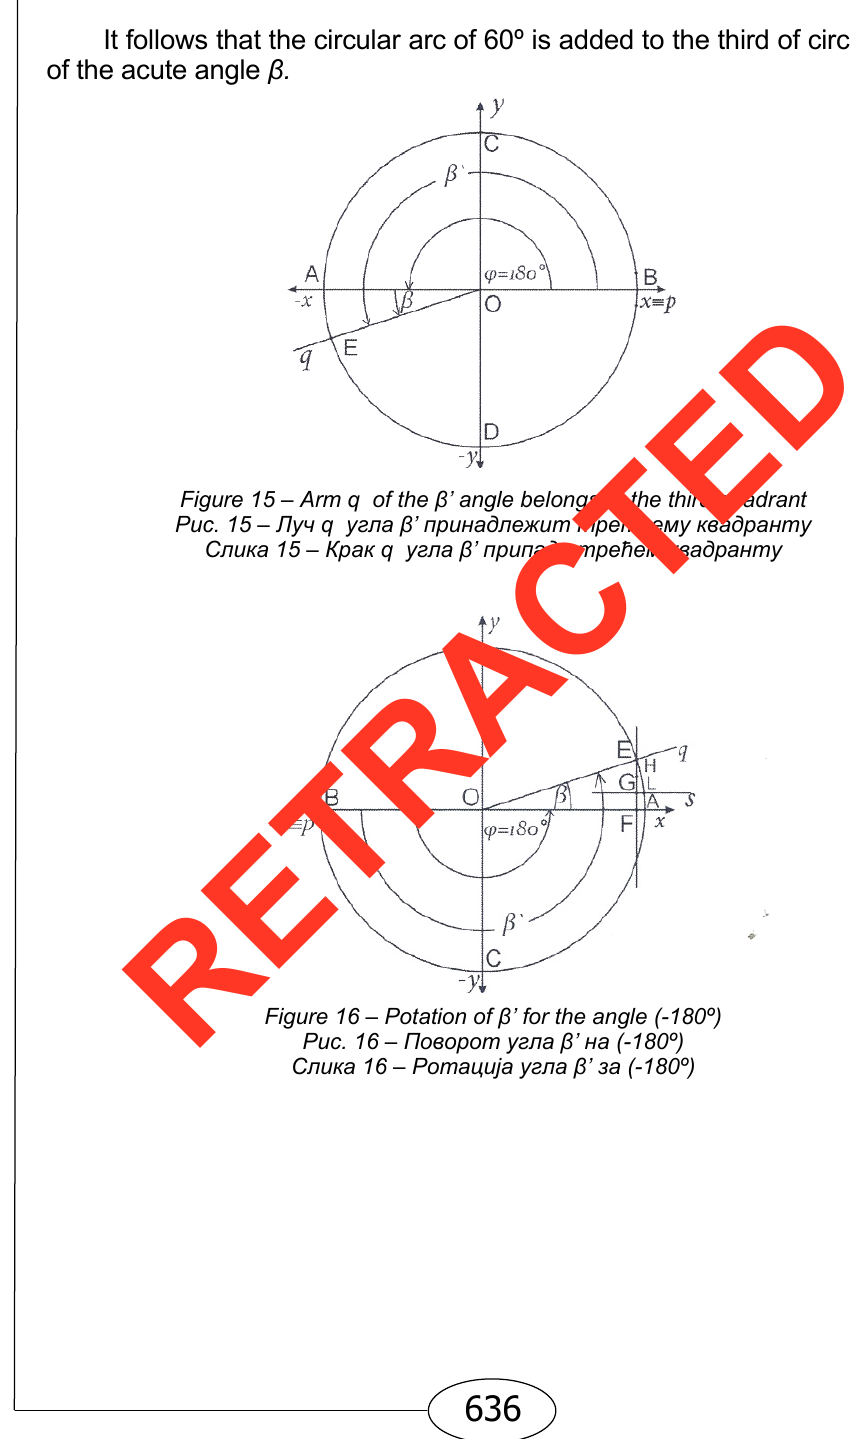
Figure 16 – Р otation of β ’ for the angle (-180º) Рис . 16 – Поворот угла β ’ на (-180º) Слика 16 – Ротација угла β ’ за